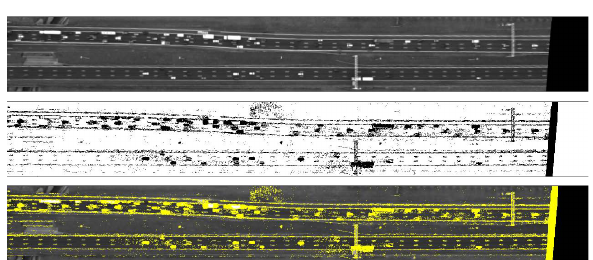
Figure 4: Background/foreground pixel identification. From top to bottom: 1) an arbitrary image, 2) discrimination of the back- ground (white) and foreground (black) pixels, and 3) the detected foreground pixels